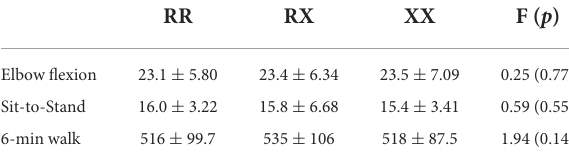
TABLE 3 Effect of genotype on strength and aerobic endurance.